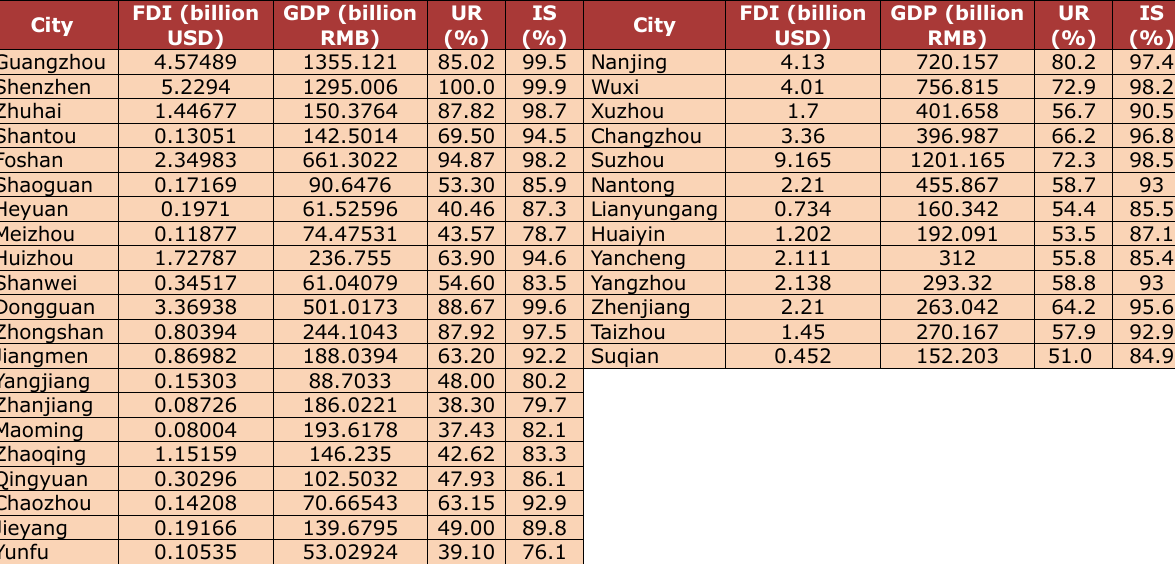
Table 1. FDI, GDP, UR and IS in 2012 of Jiangsu and Guangdong province in China